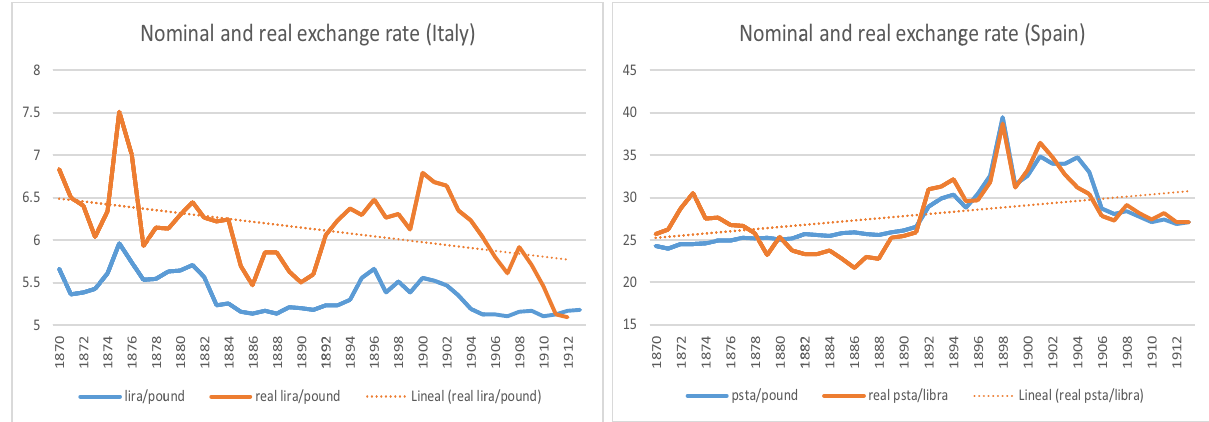
Figure 4: Nominal and real exchange rate evolution in Spain and Italy. Source: Martín Aceña and Pons ( 2005 ) , Martinez - Ruiz and Nogues - Marco ( 2014 ) , Prados de la Escosura ( 2003 ) for Spain and Ciocca and Ulizzi ( 1990 ) and Ba ffi gi ( 2013 ) for Italy. Mitchell ( 2013 ) for United Kingdom